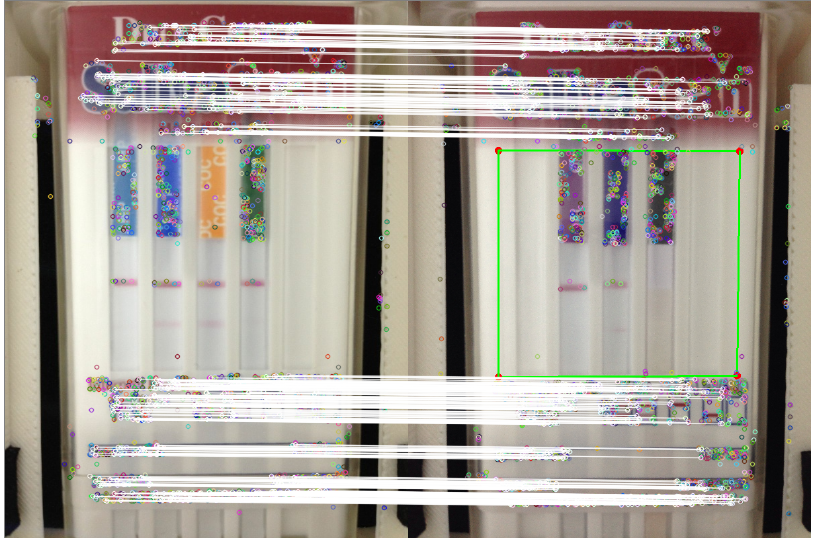
Figure 5. Matching process between oriented FAST and rotated BRIEF (ORB) descriptors in the template image ( left ) and original image ( right ). White lines denote the matched points. In green is depicted the searched region of interest that contains the strips in the actual processed